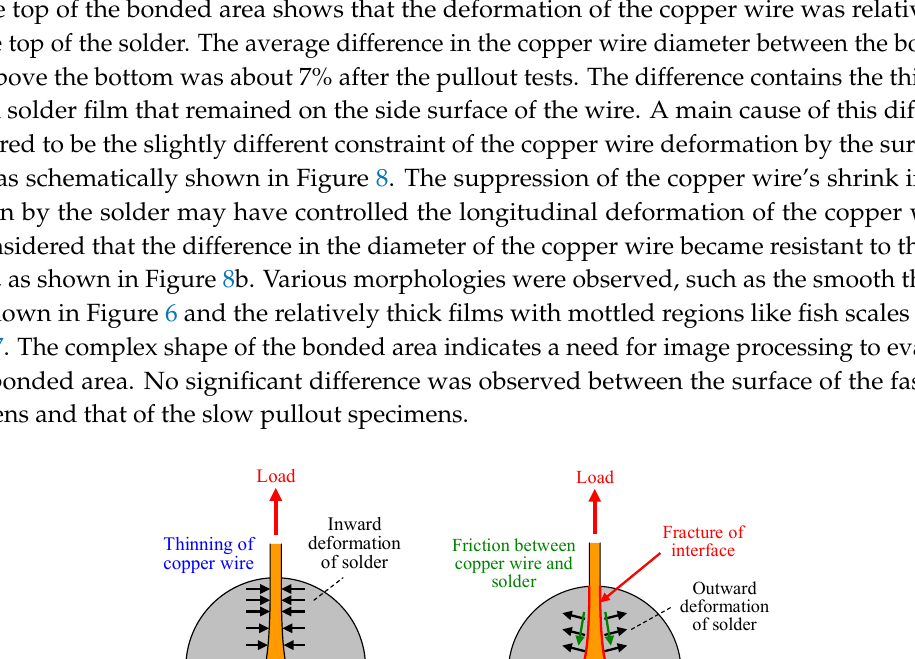
Figure 8. Deformation of copper wire and solder in pullout test: ( a ) During load increasing; ( b ) During unloading after the maximum load.